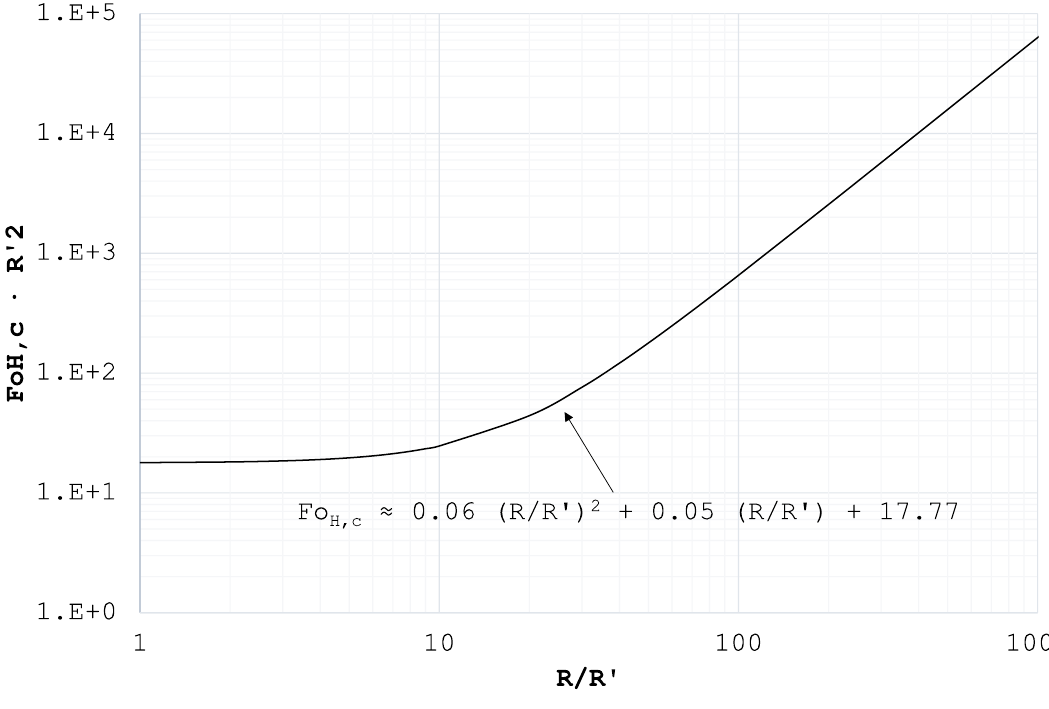
Figure 12. Fo H , c as a function of R and R (cid:48) . Fo H , c corresponds to the time after which the relative difference between the FCS and FLS models is less than